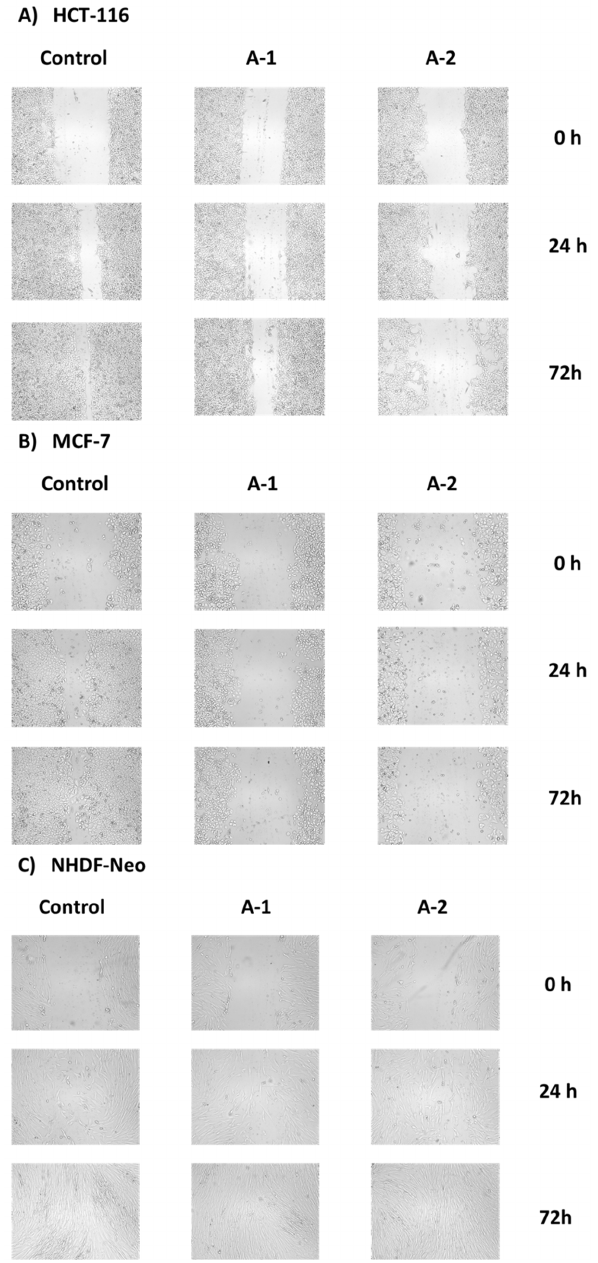
Figure 6. Representative images of: ( A ) HCT-116 cancer cells, ( B ) MCF-7 cancer cells, and ( C ) NHDF- Neo healthy cells, were acquired at time 0 and after 24 h and 72 h incubation with compounds A-1 and A-2 in wound healing assay. Better quality and larger images are included in Supplementary Materials (Figure